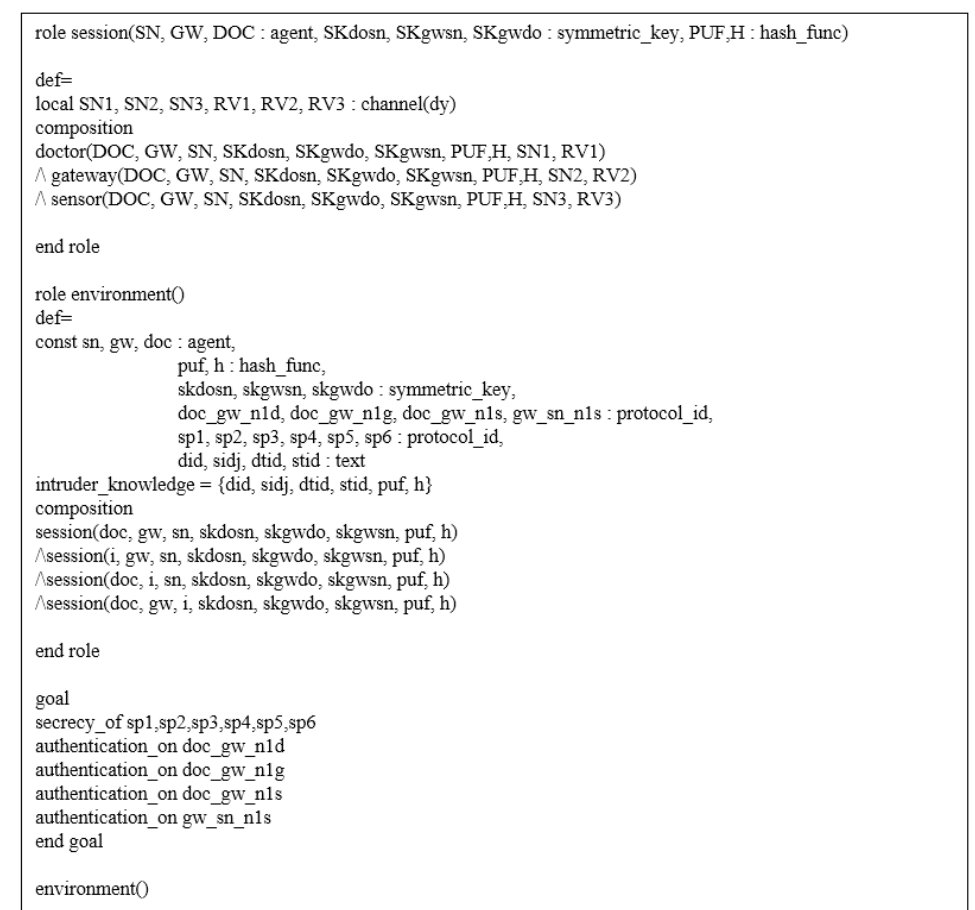
Figure 7. Role specification for the session, environment, and